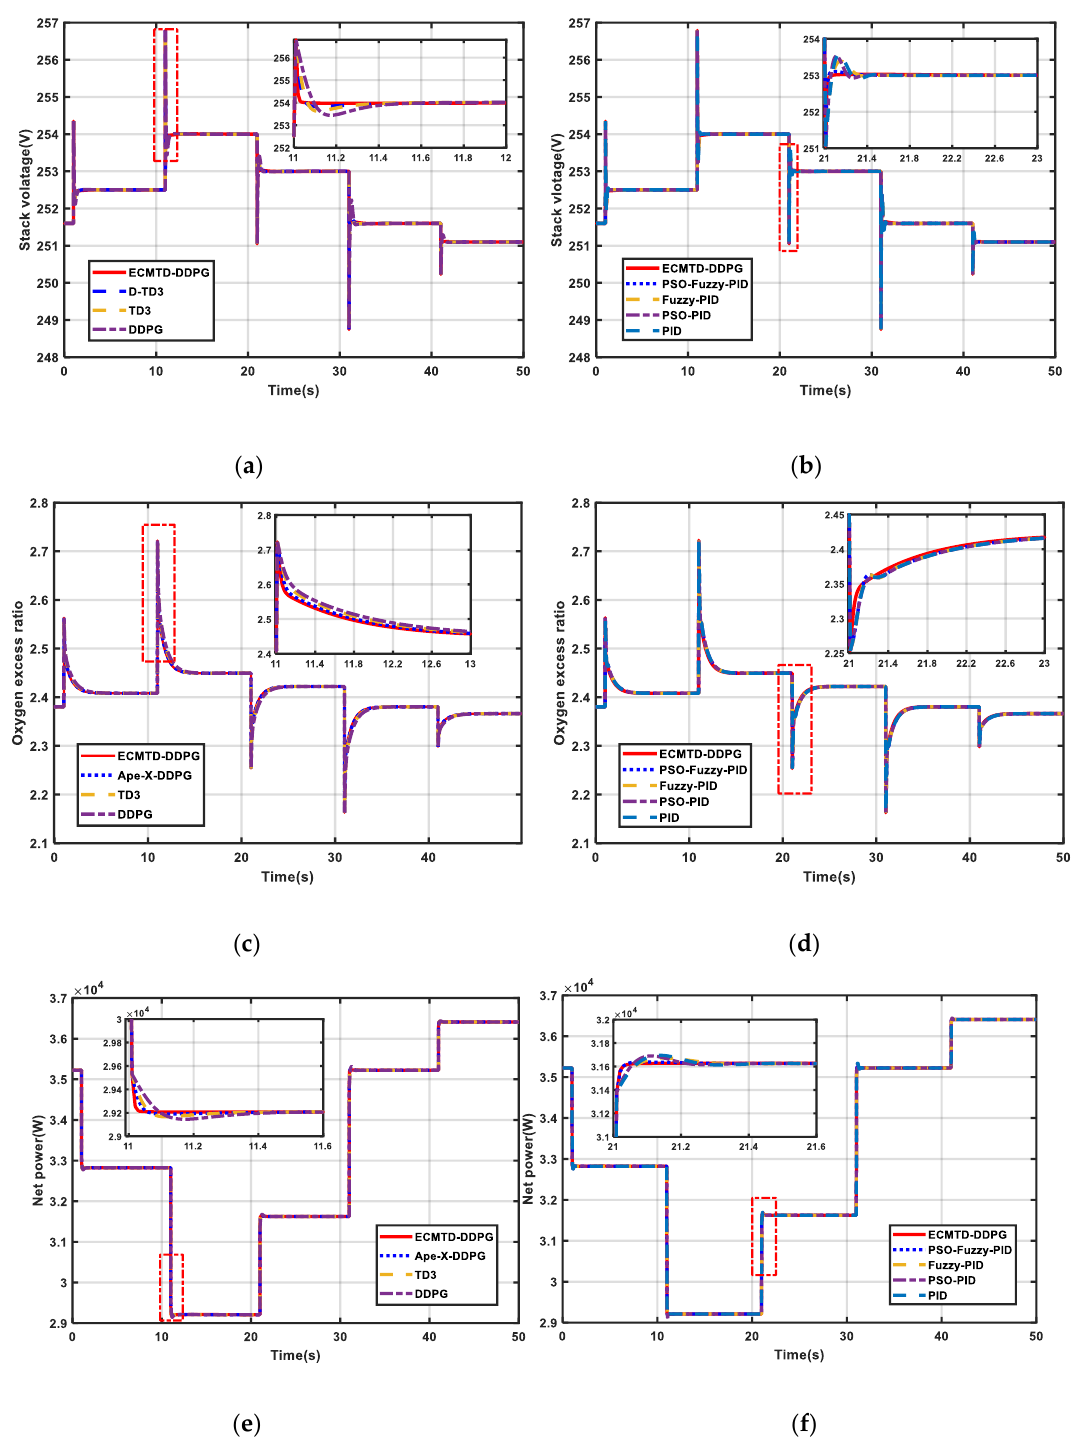
Figure 8. Simulation result of PEMFC under stochastic load ( a ) Stack voltage by RL algorithm ( b ) Stack voltage by conventional algorithm ( c ) OER by RL algorithm ( d ) OER by conventional algorithm ( e ) Net power by RL algorithm ( f ) Net power by conventional algorithm.